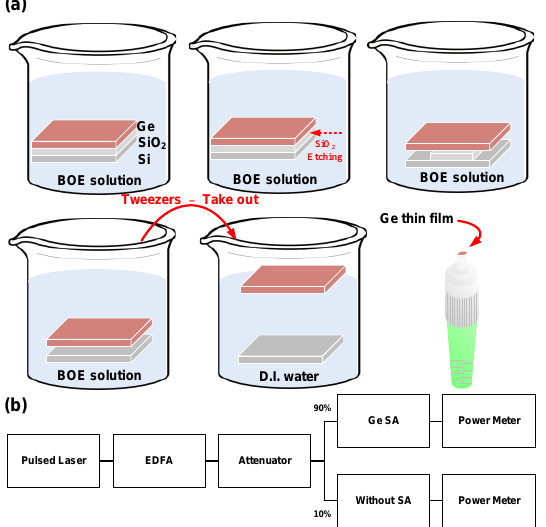
Figure 2. ( a ) The exfoliation process of the Ge thin-film. ( b ) Measured system of the nonlinear trans- mittance.